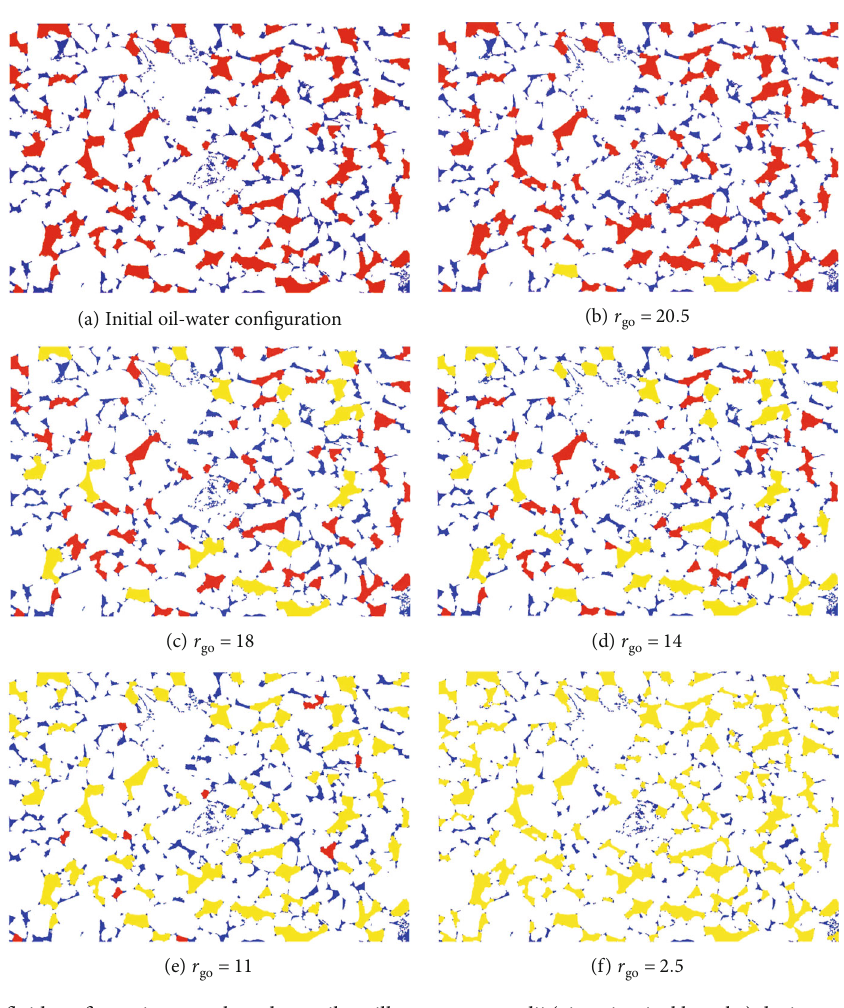
Figure 9: Three-phase fl uid con fi gurations at selected gas-oil capillary pressure radii (given in pixel lengths) during gas invasion at a constant = 5 pixel lengths ( P = 1 : 9608 × 10 4 Pa), in a strongly water-wet nonspreading system. Yellow region: oil-water capillary pressure radius, r ow cow gas; red region: oil; blue region: water.